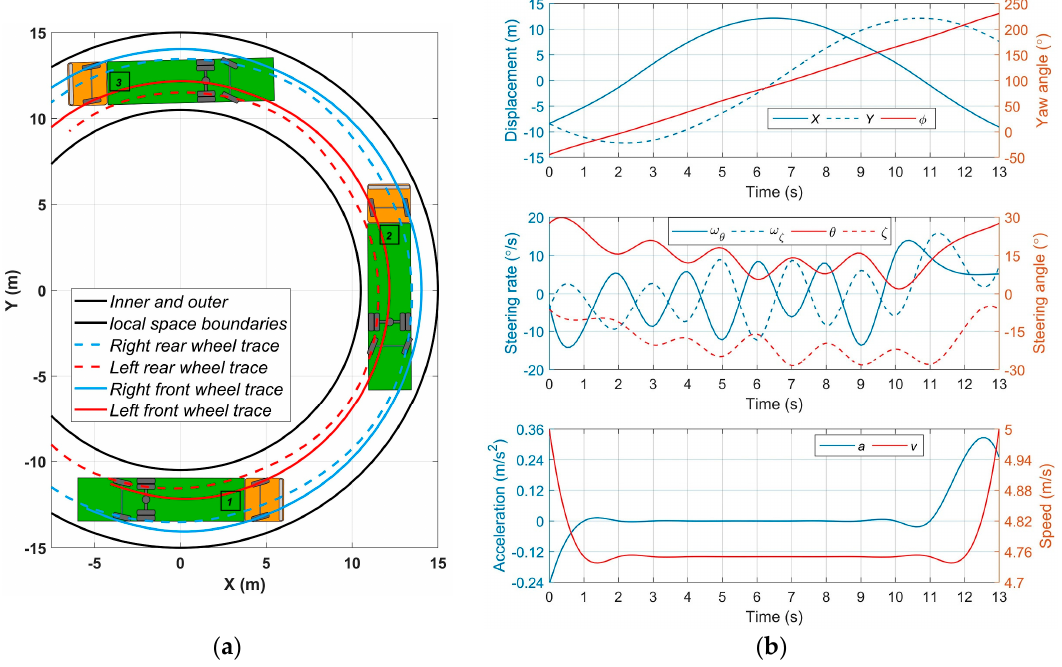
Figure 6. Simulation results for the single truck circular motion: ( a ) Truck positions and planned trajectories; ( b ) Truck output and control parameters.